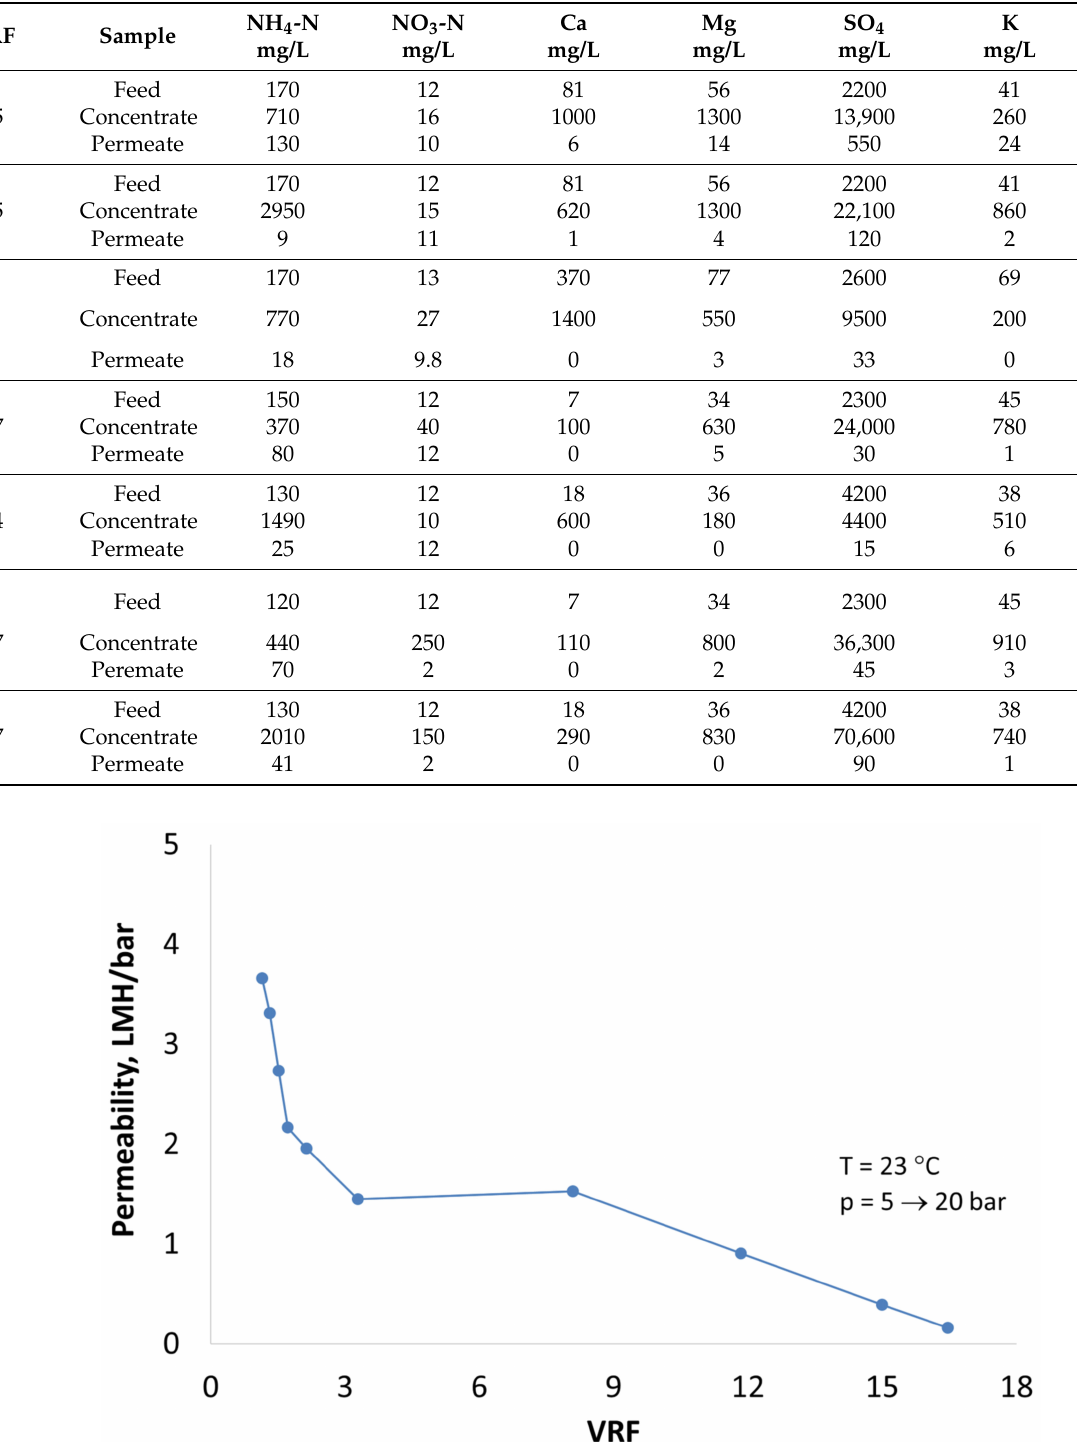
Figure 5. Permeability of C 2 H 2 O 4 -precipitated mine water when using NF90-2540 spiral wound